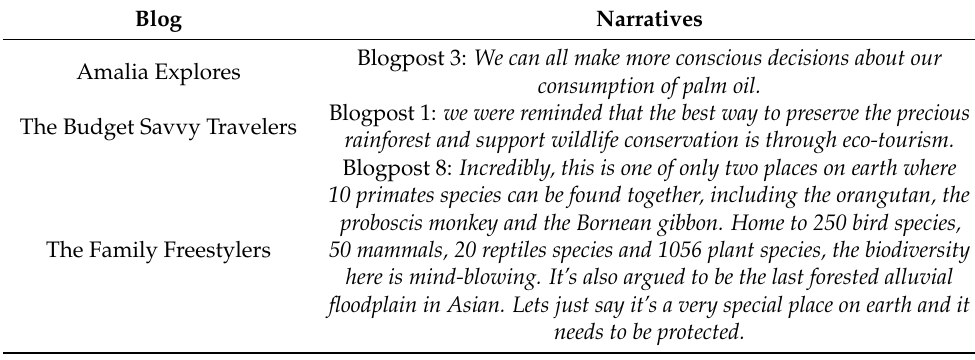
Table 7. Emotional Narratives on Theme